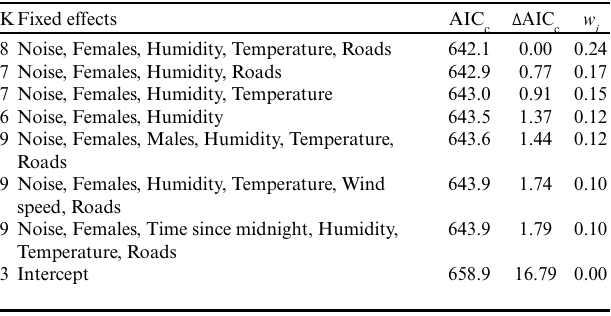
Table 3 . Model selection for environmental variables influencing area of Greater Prairie-Chicken ( Tympanuchus cupido ) boom chorus (km²) surrounding a lek near Ainsworth, Brown County, Nebraska, USA, 2013–2014. Only candidate models within 2 AIC (Akaike Information Criterion adjusted for small sample size)